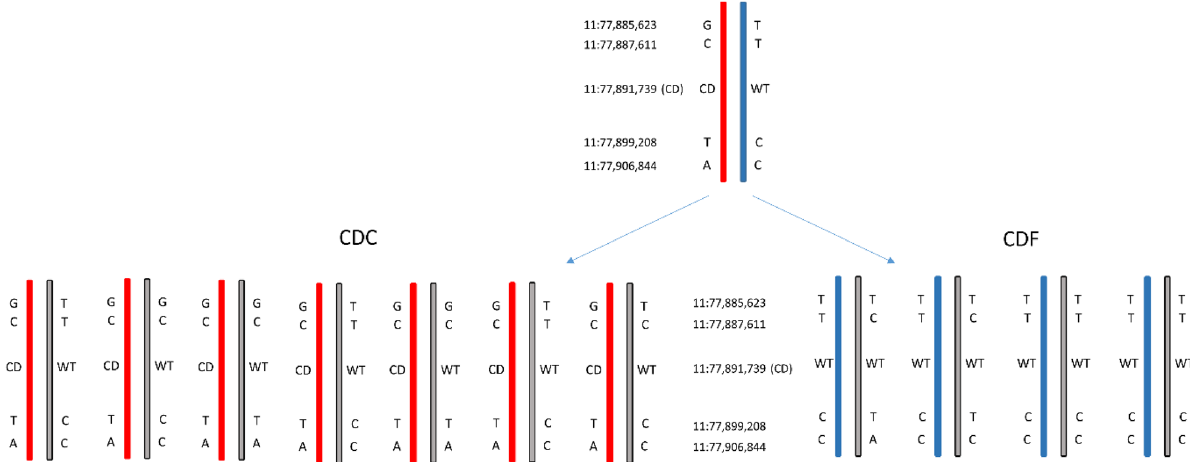
Figure 1. Identification of a haplotype carrying the CD mutation. Haplotype distribution of seven CDC and four CDF half-sib offspring of a CDC carrier sire for the chromosomal region on BTA11: 77,885,623–77,906,844 comprising the site of LTR retrotransposon insertion in the APOB gene causal for the CD defect. CD denotes the mutated allele of the APOB gene at position 11:77,891,739, WT denotes the wild type